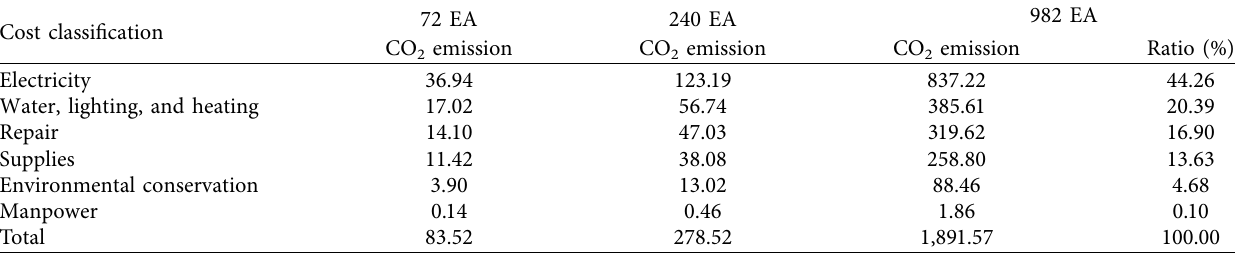
Table 6: CO 2 emissions generated by in-plant production environmental factors.